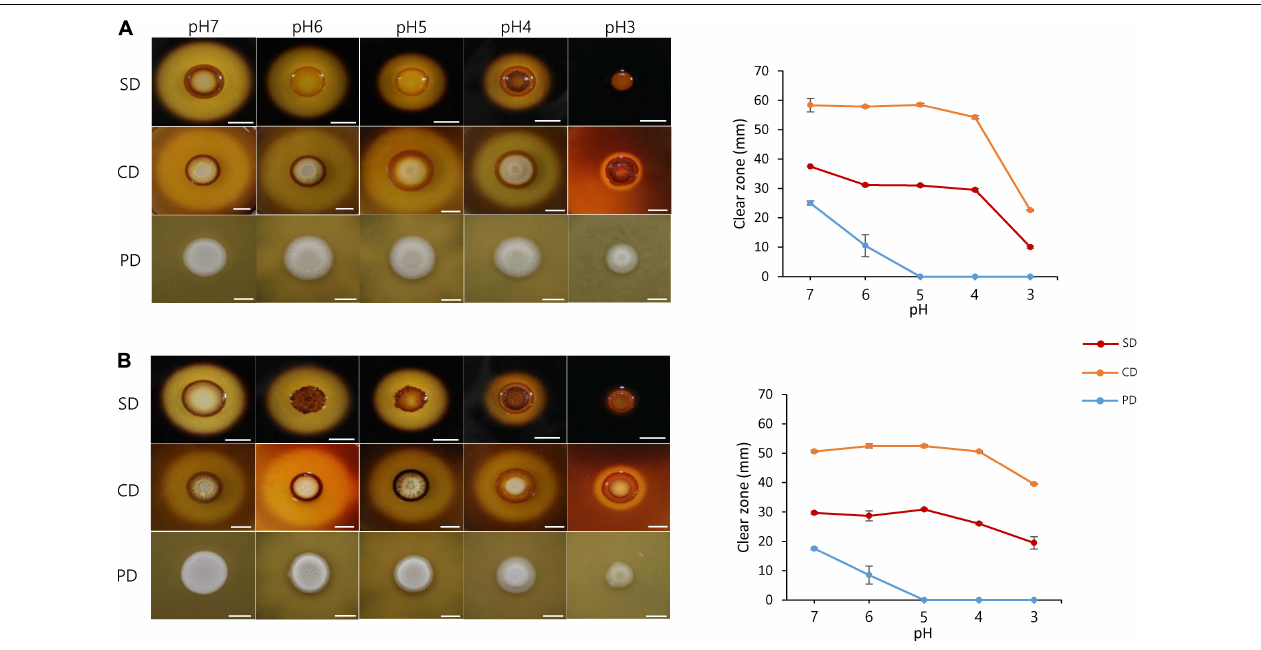
FIGURE 3 | Starch, cellulose, and protein degradation by Saccharomycopsis fibuligera . KPH12 strain (A) and KJJ81 interspecies hybrid strain (B) grown on YPG agar buffered at pH 7, pH 6, pH 5, pH 4, and pH 3 at 25 ◦ C. Degradation assays for starch, cellulose, and proteins were performed by adding 0.2% starch, 0.2% carboxymethylcellulose, and 2% skim milk. The results for starch degradation were obtained 3 days after incubation, and the results for cellulose and protein degradation were obtained 5 days after incubation. SD, starch degradation; CD, cellulose degradation; PD, protein degradation; scale bar = 10 mm.